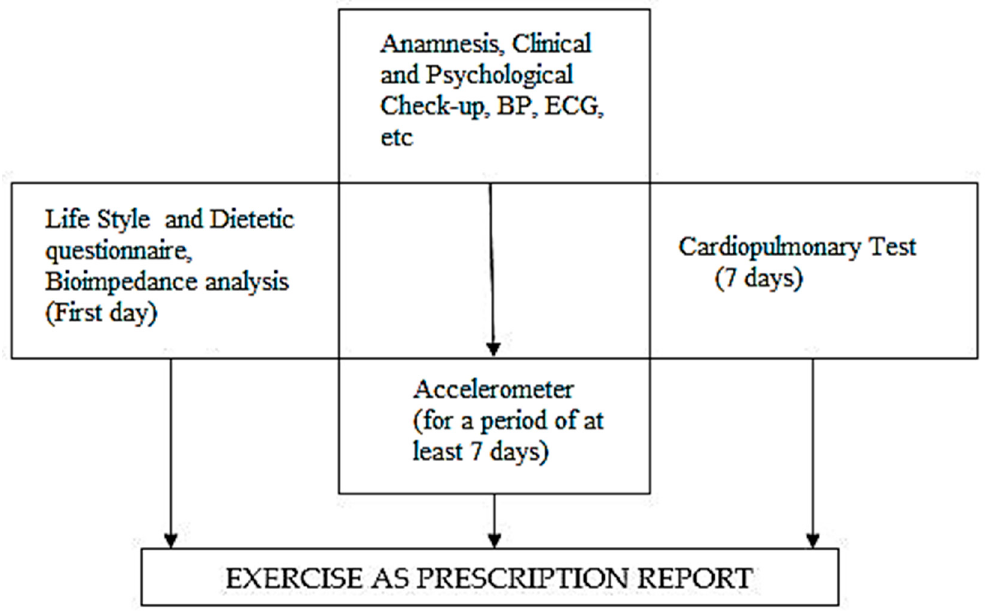
Figure 1. The figure shows the chronological sequence of the “exercise on prescription program”. The flow-chart shows the chronological sequence of the “exercise on prescription program”.